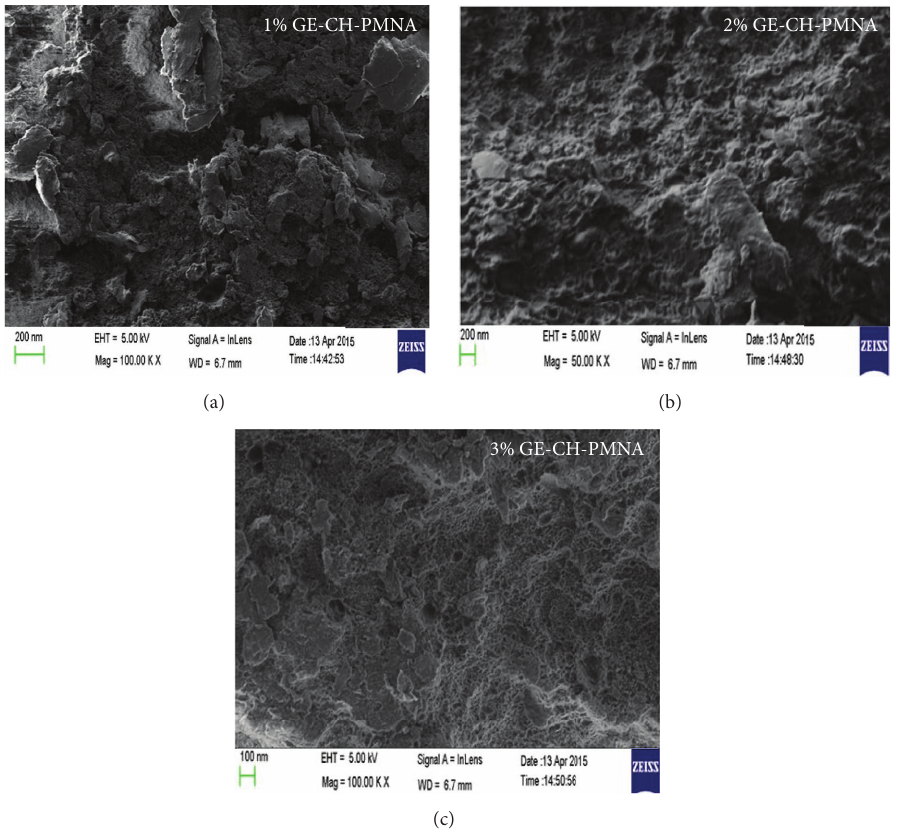
Figure 3: SEM images showing cross sections of GE-CH-PMNA composites with 1wt%, 2wt%, and 3wt% of CH,